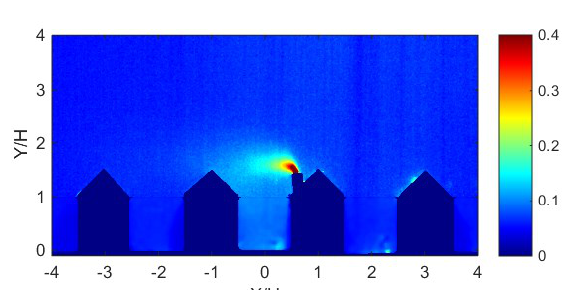
Fig. 16. Mean non- dimensional concentration C/C 0 field (C 0 is the mean concentration measured at the top of the chimneystack) for pitched roof and a chimneystack (on the downstream pitch) with h/H = 0.50; the flow moves from the right to the left.